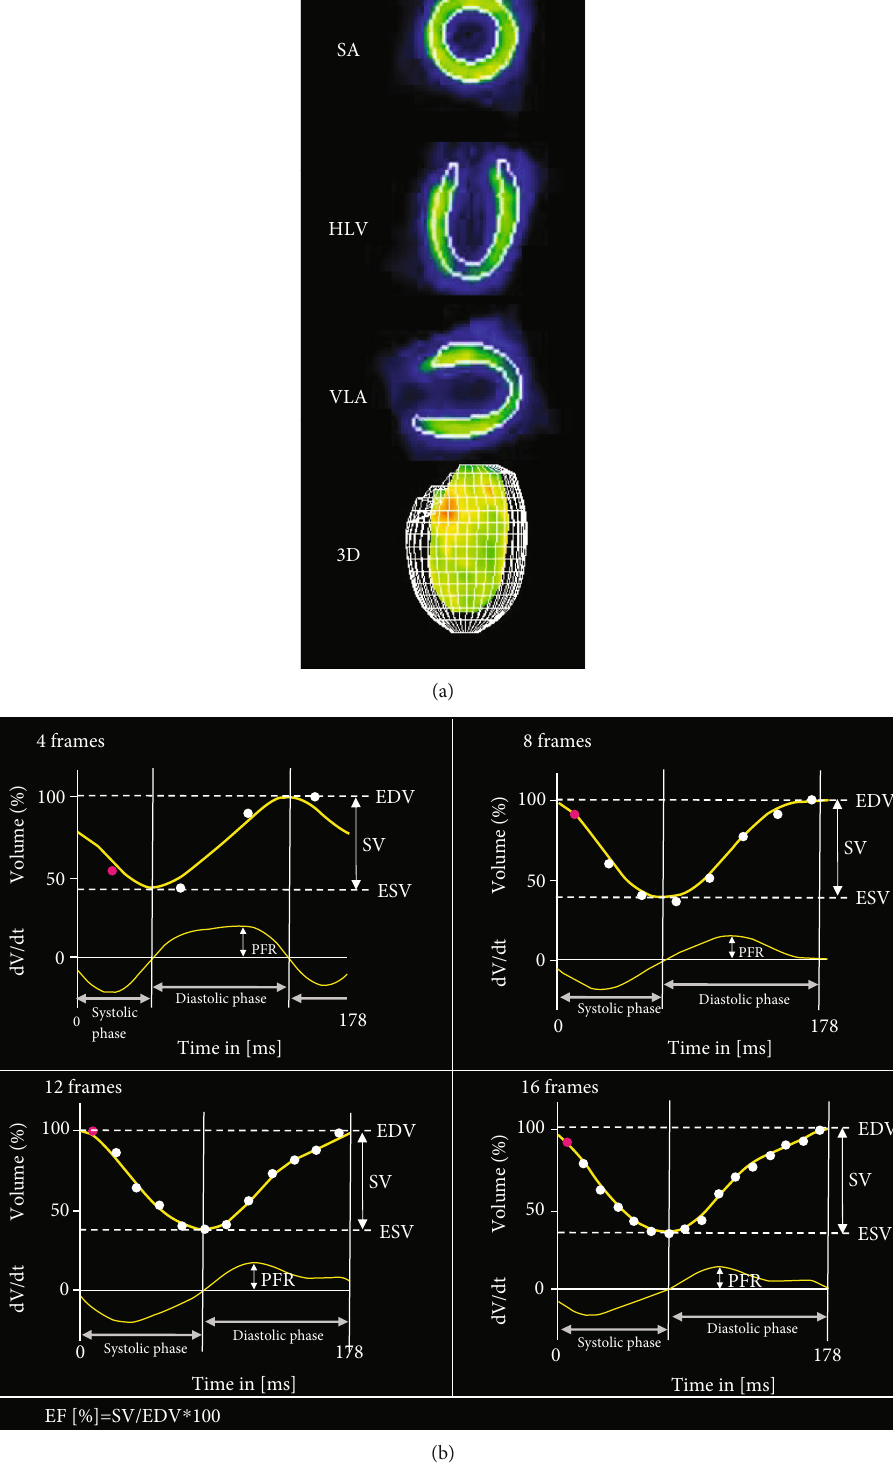
Figure 3: Example images of the edge detection of left ventricular wall and 3D images of the ventricular borders (a). Time-volume curves (b) and corresponding time- fi lling curve of the same animal with di ff erent numbers of gates per cardiac cycle. The smoothening of both curves due to the increasing number of volume values with increasing gate number is demonstrated as well as the calculation of the LV volumes and the PFR. EDV: end-diastolic volume; ESV: end-systolic volume; SV: stroke volume; EF: ejection fraction; PFR: peak fi lling